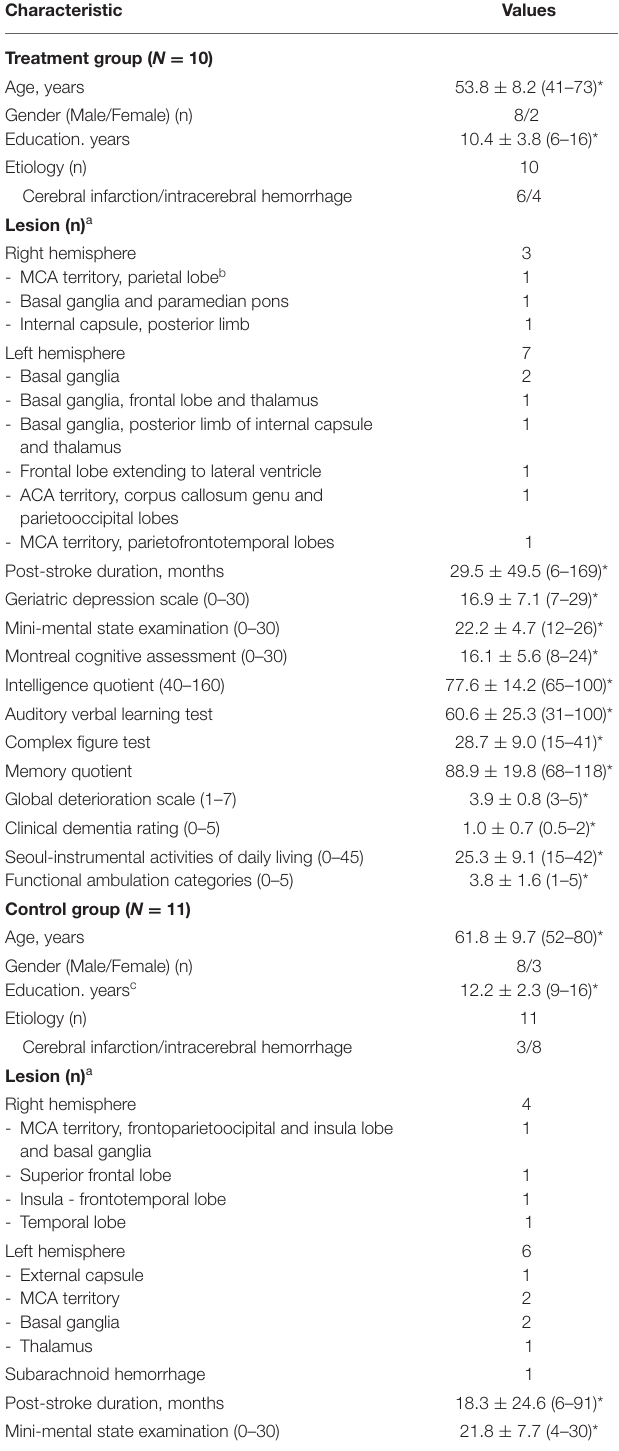
TABLE 1 | Demographic characteristics of the patients.